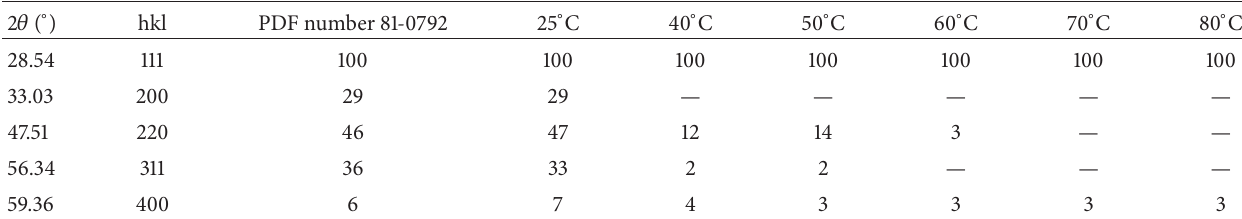
Table 2: The preferred orientation of CeO (data from Figure